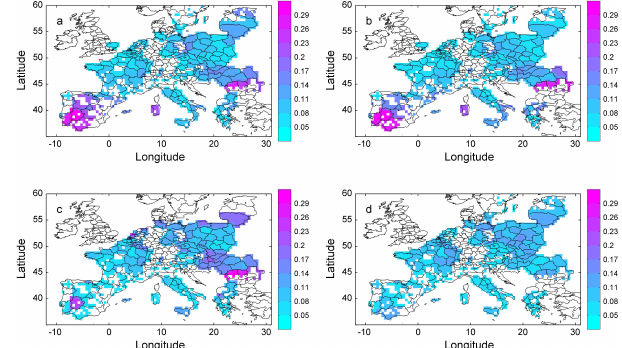
Figure 1. Spatial patterns of CV of detrended crop yield data during the 1975–2009 period for barley (a) , wheat (b) , grain maize (c) and potatoes (d) . Blank region indicates that there is intensive irrigation (with irrigated area fraction ≥ 15%), no crop yield records or a very low ( < 5%) fraction of croplands in those